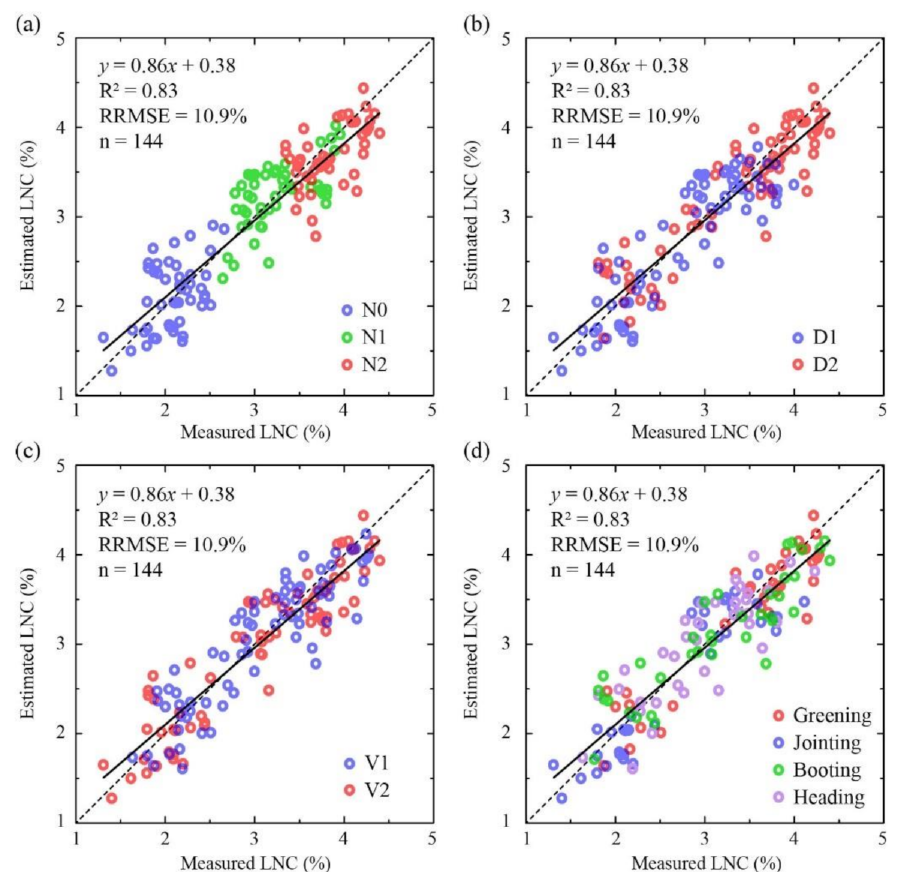
Figure 7. The validations of LNC estimations based on the optimal indices of NDSTI ( R 931.88 , T 432.38SM ) of the all leaves (AL) object under ( a ) different nitrogen rates, ( b ) different planting densities, ( c ) different wheat varieties, and ( d ) in different growth stages. The descriptions of different conditions are given in Table